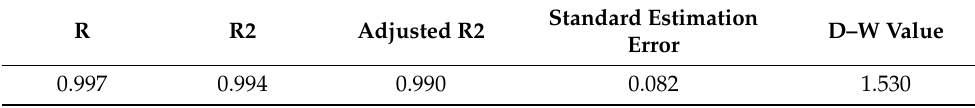
Table 9. ANOVA for surface roughness.